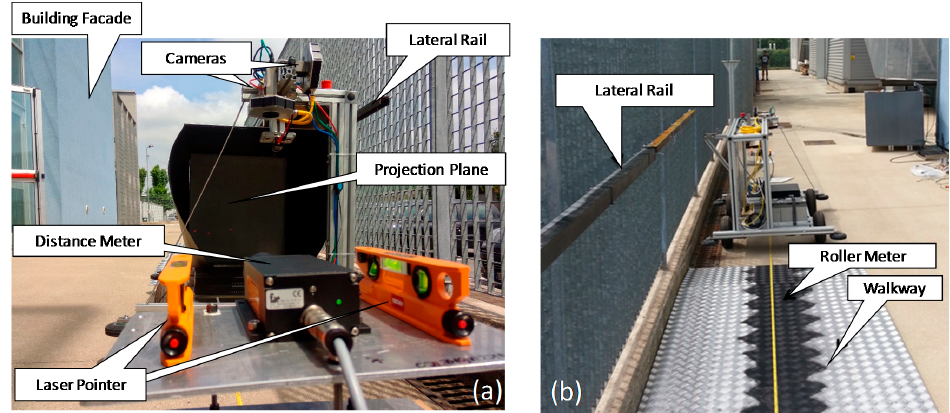
Figure 10. Pictorial views of the experimental setup used for the method validation. Rear ( a ) and